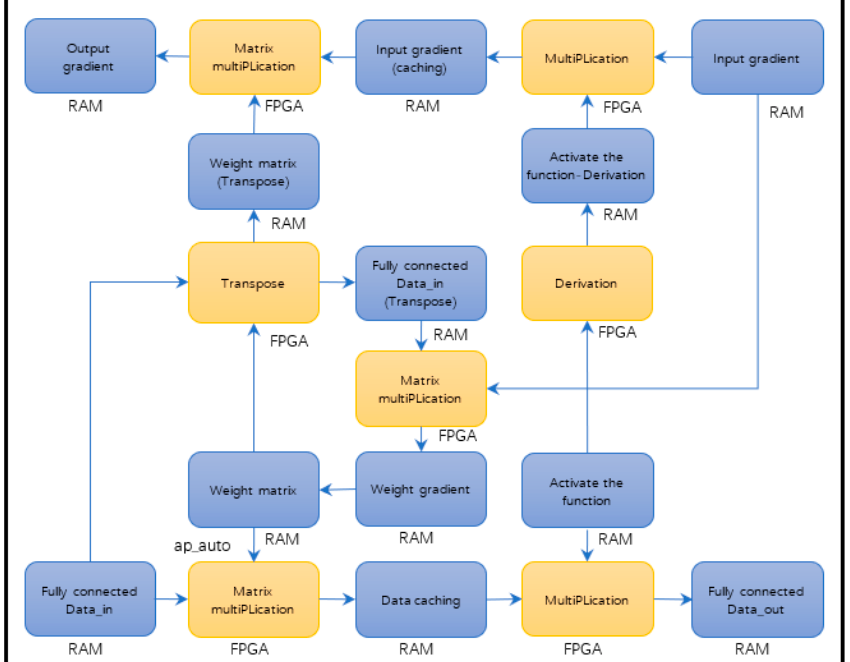
Figure 9. Realization of forward propagation and backpropagation of the full connection layer.